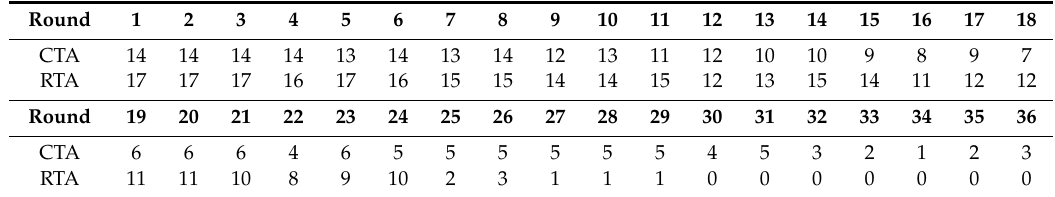
Table 1. The number of segments included in the